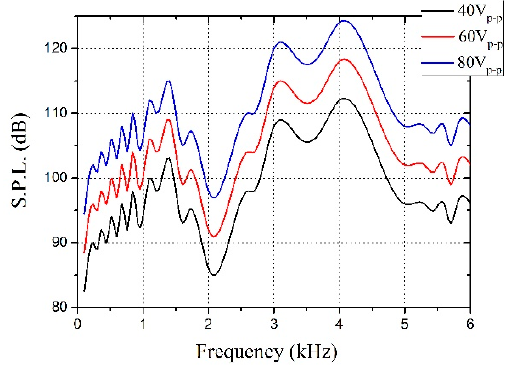
Figure 6. Relationship between sound pressure level (S.P.L.) and acoustic frequency (distance from the sound source: 10 cm).